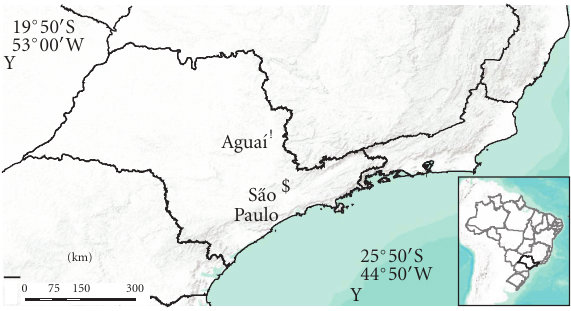
Figure 1: Location of the Agua´ı experimental catchment in the State of S˜ao Paulo,